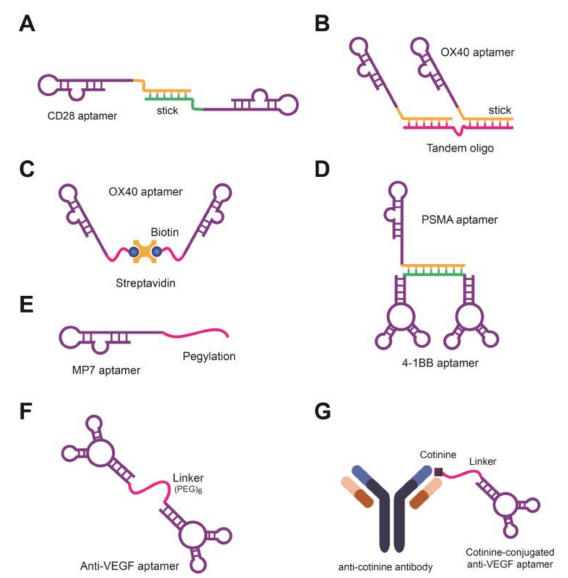
Figure 1. Schematics of aptamers used as agonists or antagonists against cancer biomarkers. ( A ) Bivalent CD28 aptamer conjugate. CD28 aptamers are linked through 21 base-paired double-stranded RNA molecules; ( B ) Bivalent OX40 aptamer conjugate. The 3 (cid:48) -end stick sequence of OX40 aptamers are annealed to a DNA scaffold; ( C ) Bivalent OX40 aptamer conjugate. Biotin modified OX40 RNA aptamers are assembled via streptavidin; ( D ) Bispecific PSMA-4-4BB aptamer conjugate. A PSMA aptamer and bivalent 4-1BB aptamer are non-covalently annealed with a stick sequence; ( E ) An MP7 aptamer is conjugated with PEG; ( F ) Bivalent anti-VEGF aptamer. Two aptamers are tethered through a hexaethylene glycol spacer; ( G ) Anti-VEGF aptamer-antibody conjugate. This “oligobody” was developed to improve in vivo therapeutic